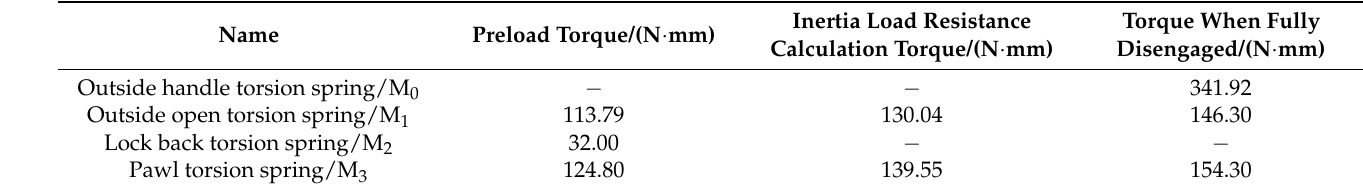
Table 2. Torsion of torsion spring.